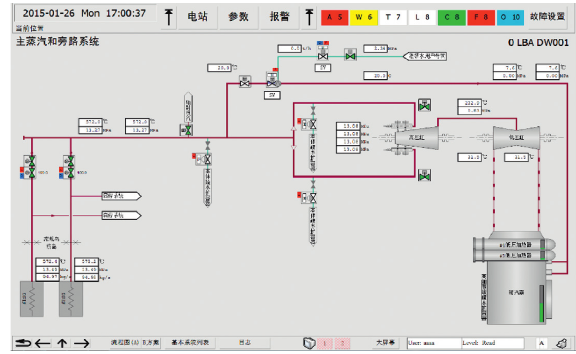
Figure 6: HMI for the main steam system in vPower code.